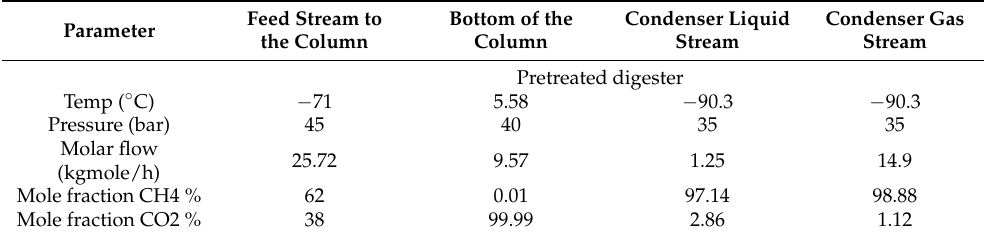
Table 7. Pressure, temperature, and input and output of the distillation column in pretreated feed- cryogenic separation.